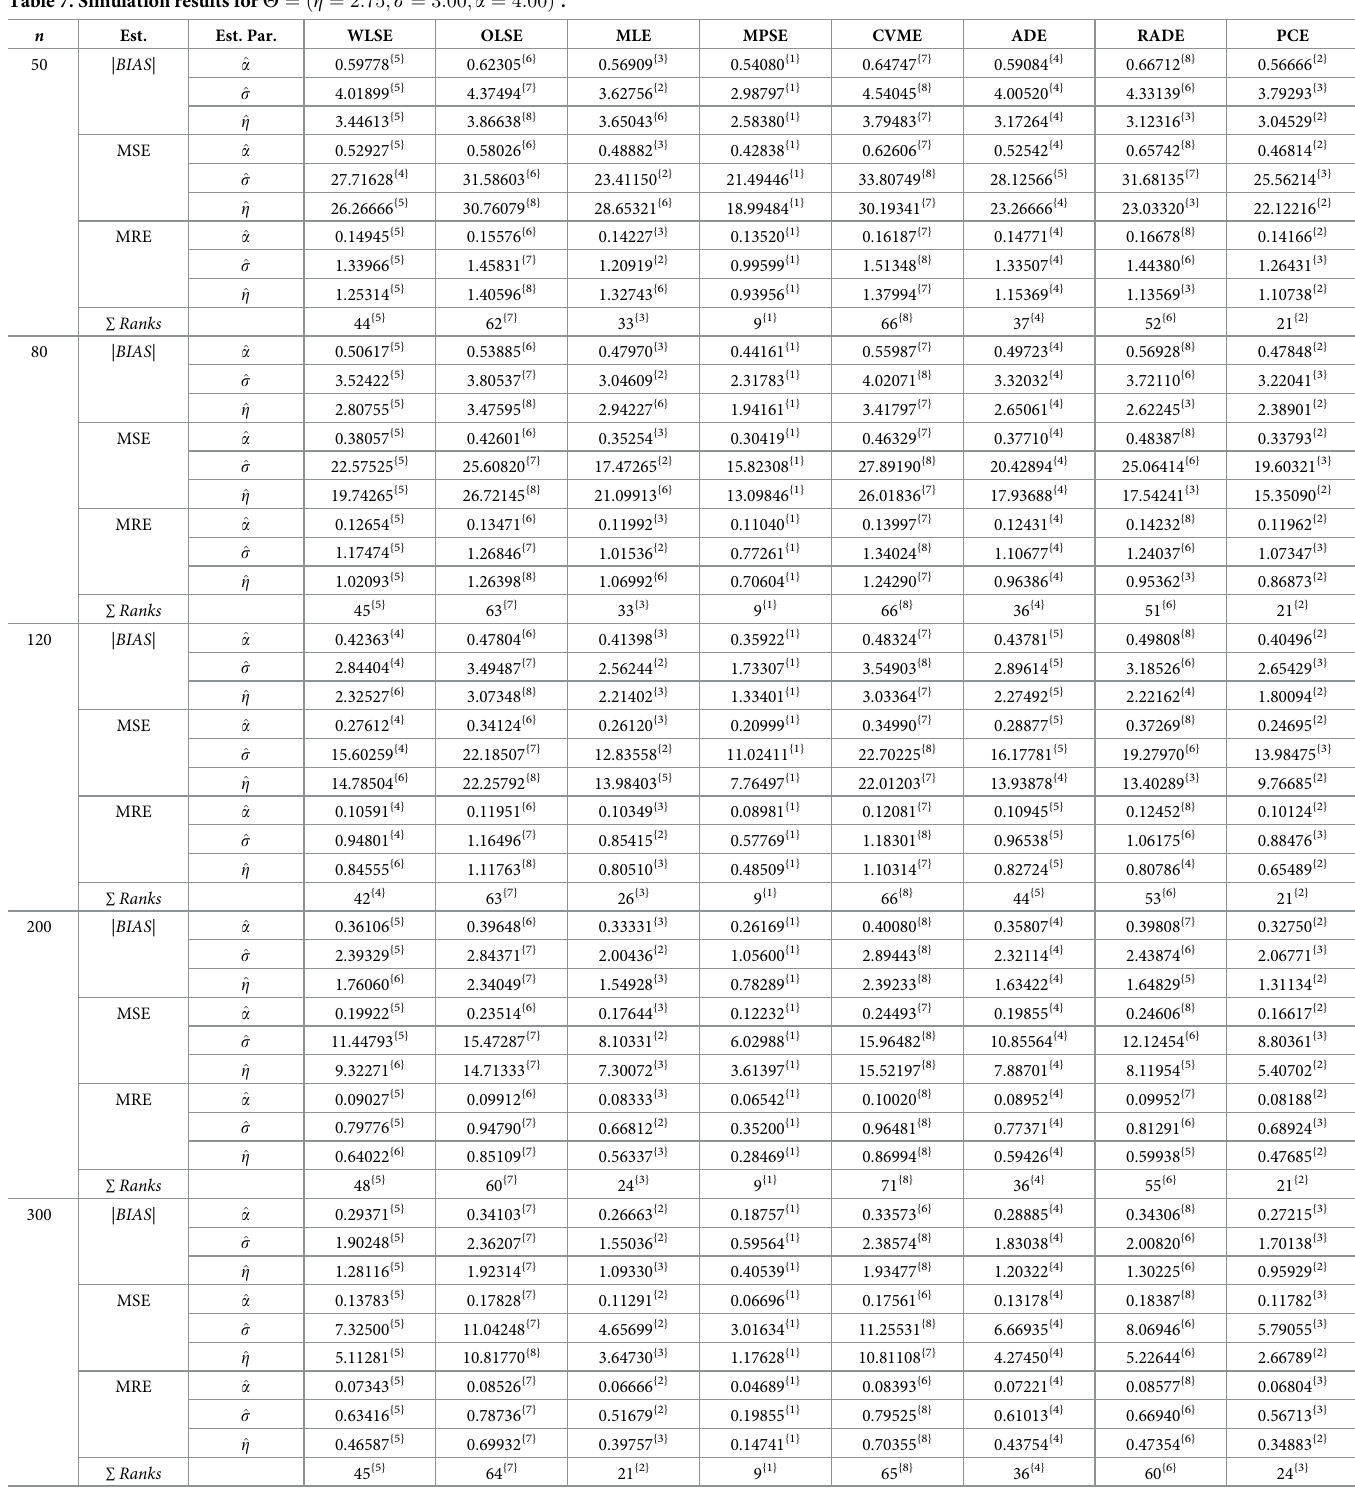
Table 7. Simulation results for Y ¼ ð Z ¼ 2 : 75 ; s ¼ 3 : 00 ; a ¼ 4 : 00 Þ ⊺ . n